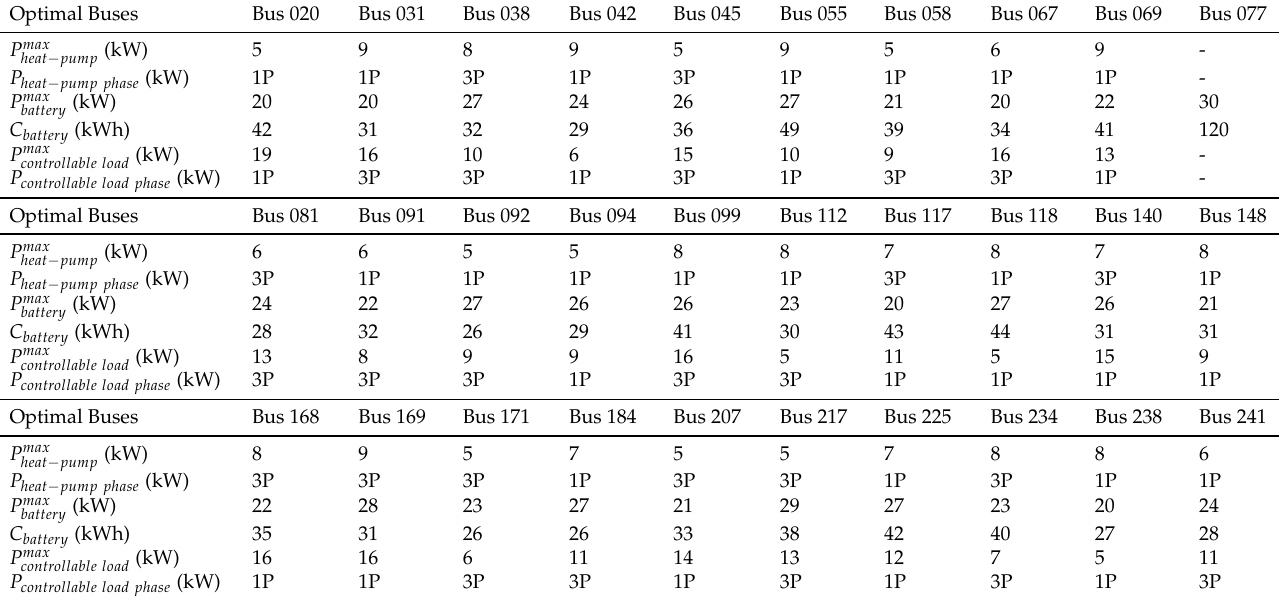
Table 2. Simulation parameter limits for optimal buses.